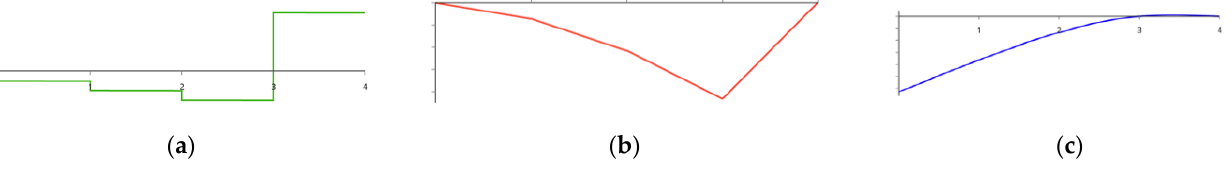
Figure A12. Cantilevered system beam free-body diagram. The shear force, bending moment, and deflection diagrams are qualitatively illus- trated in Figure A13a – c.